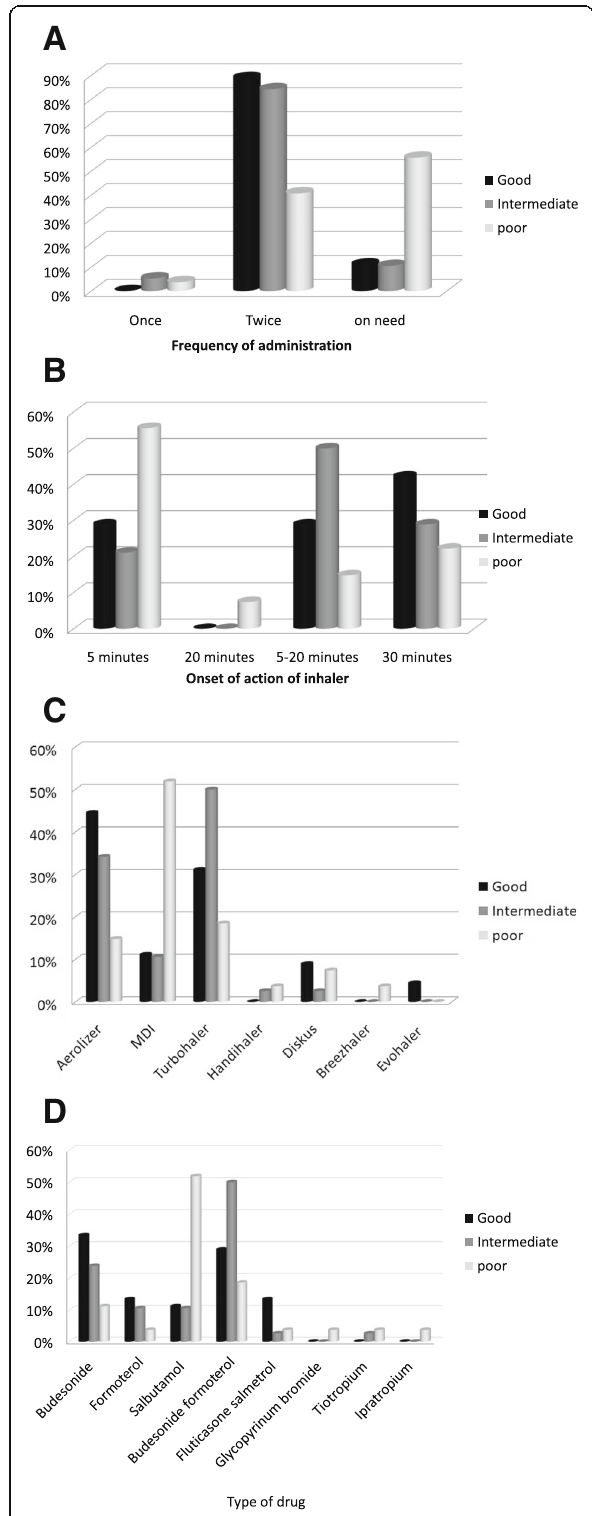
Fig. 2 The relation between drug characteristics and adherence pattern in asthma patients. a Frequency of administration. b Onset of action of inhaler. c Type of device. d Type of